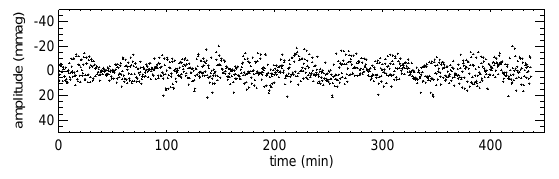
Figure 1. Light curve of PG 1613+426 for June 19th, 2017.